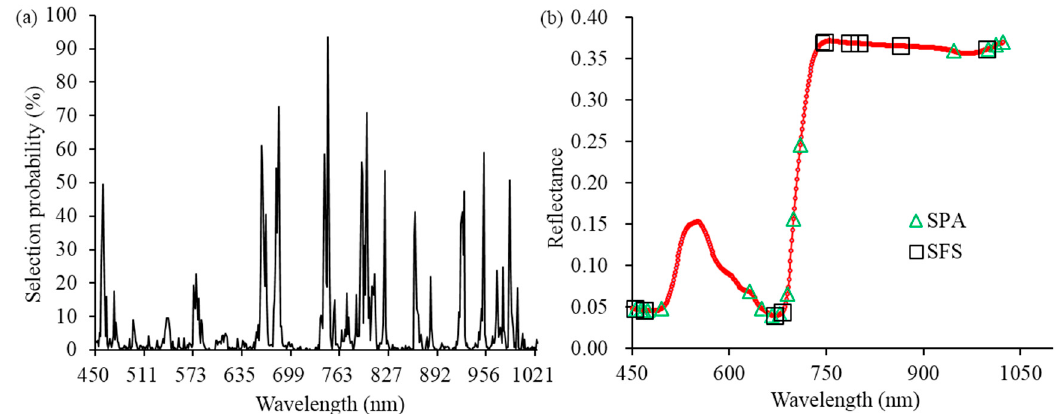
Figure 3. ( a ) The selection probability of each wavelength for SSR detection by random frog (RF). ( b ) The selected wavelengths for SSR detection by successive projections algorithm (SPA) and sequential forward selection (SFS), respectively.